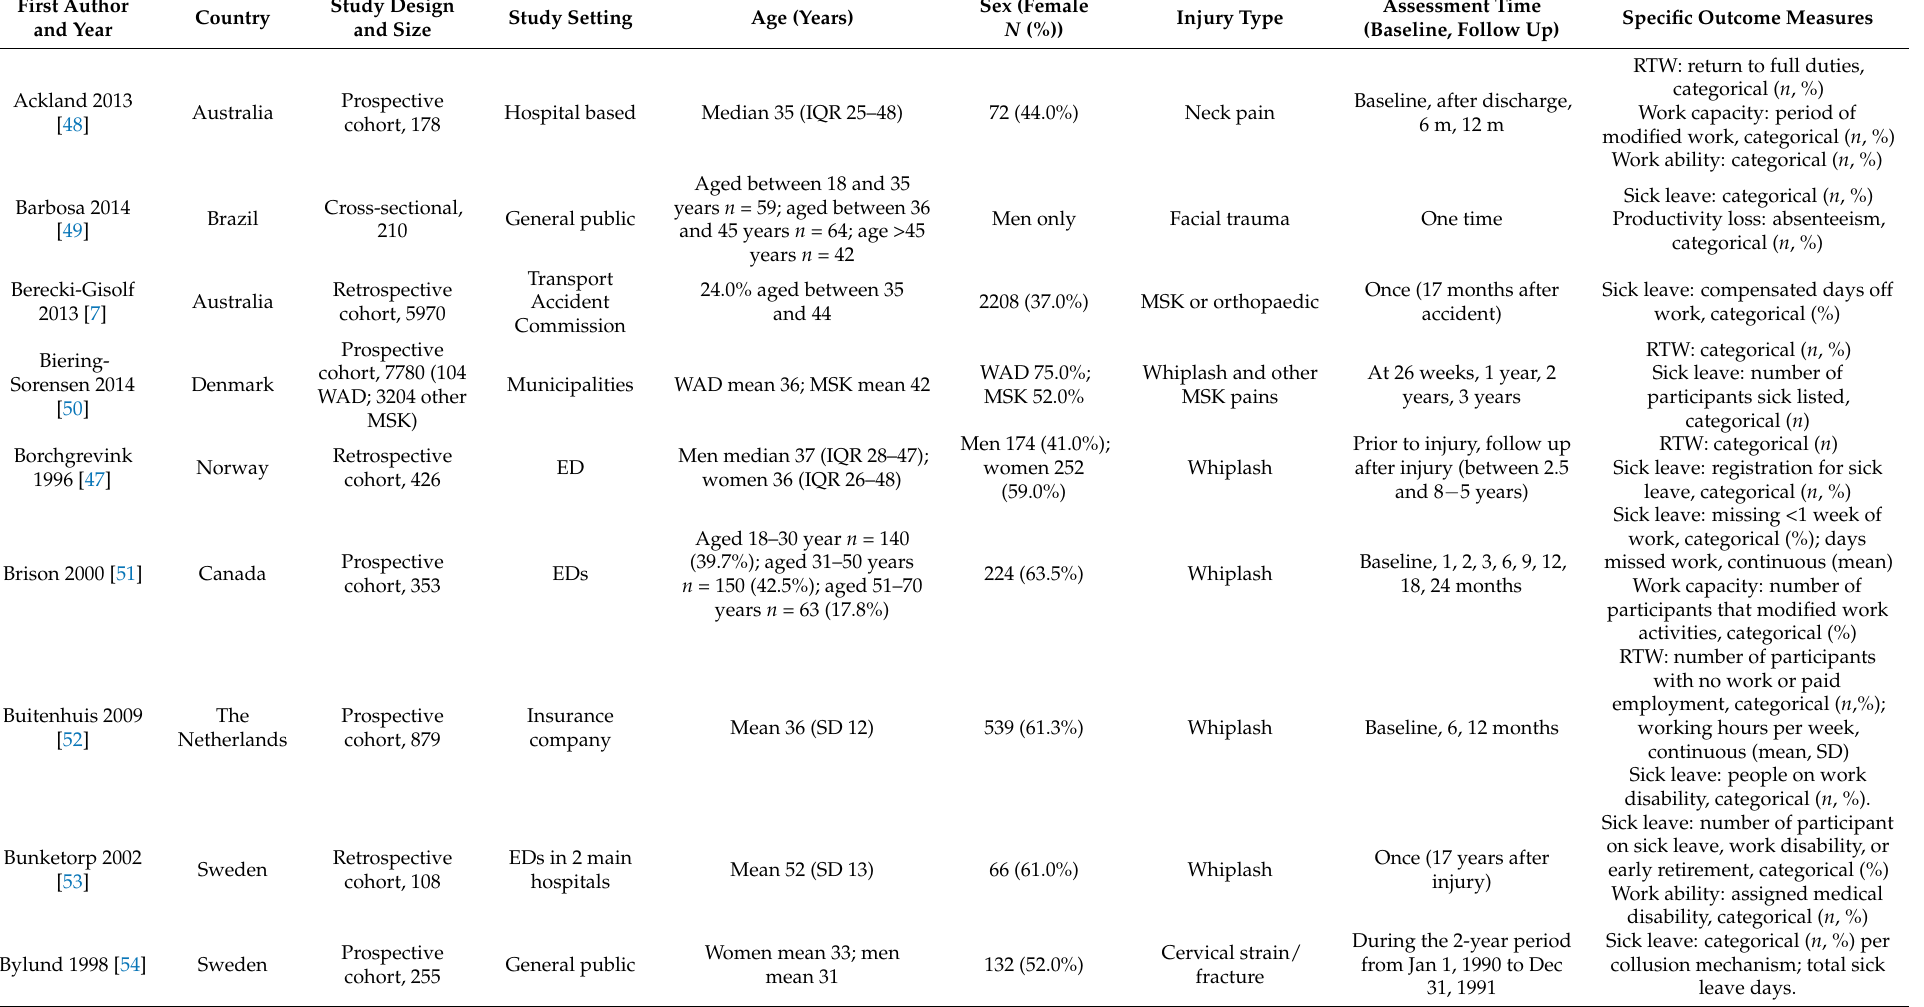
Table 1. Study characteristics of included